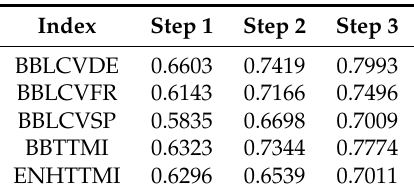
Table 9. Comparison of the ratios of RMSE for models for intermediate goods with an expanding window from 2008:01 to 2018:12.